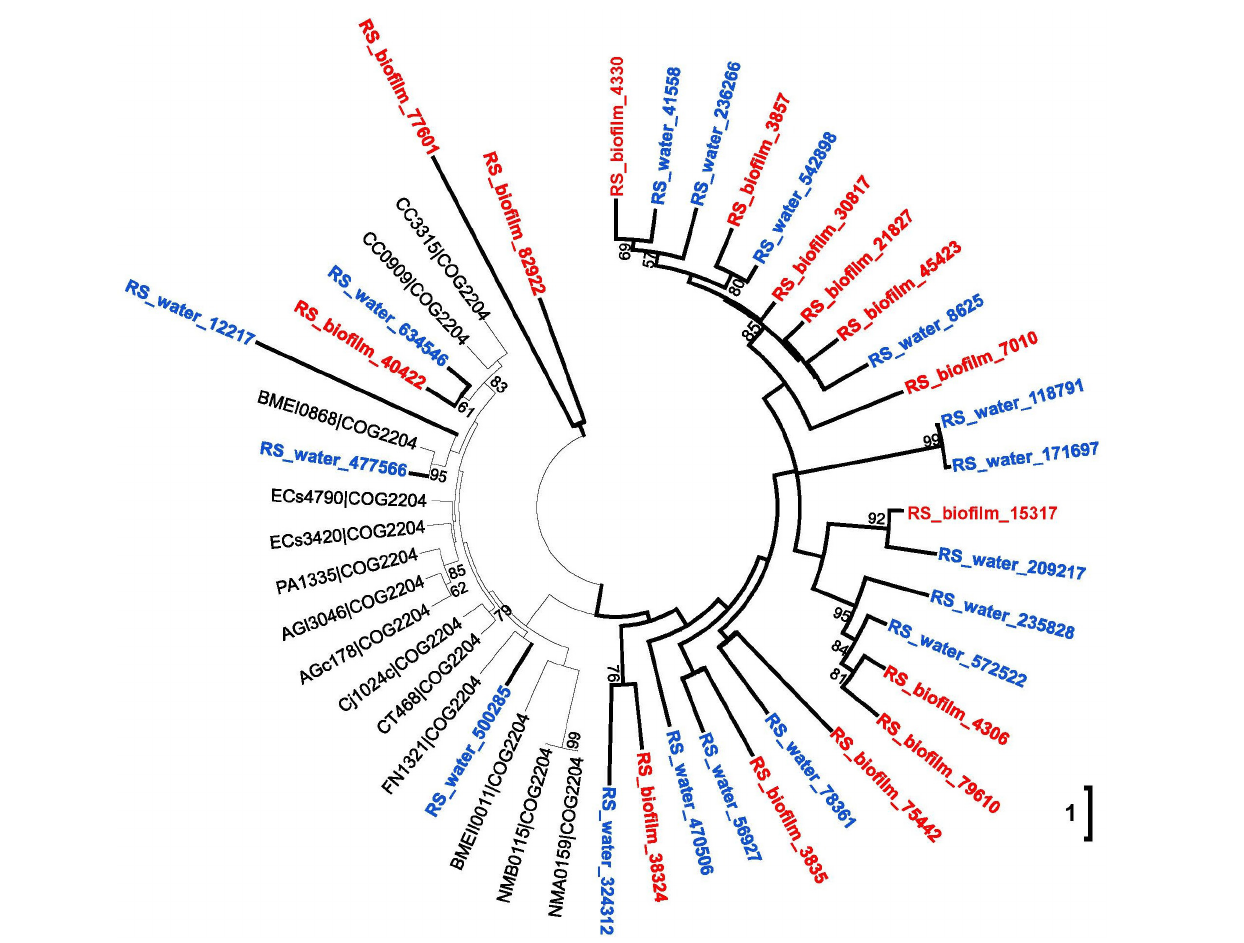
FIGURE 6 | Phylogenetic tree of the response regulator subunit COG2204 identified from the Red Sea biofilm and seawater microbial communities. The protein sequences that could be aligned by ClustalW were used to construct a maximum likelihood tree with 1,000 replicates. Bootstrap values ( > 50) are shown on the branches. The independent branch indicated the high sequence similarity between proteins from biofilm and seawater